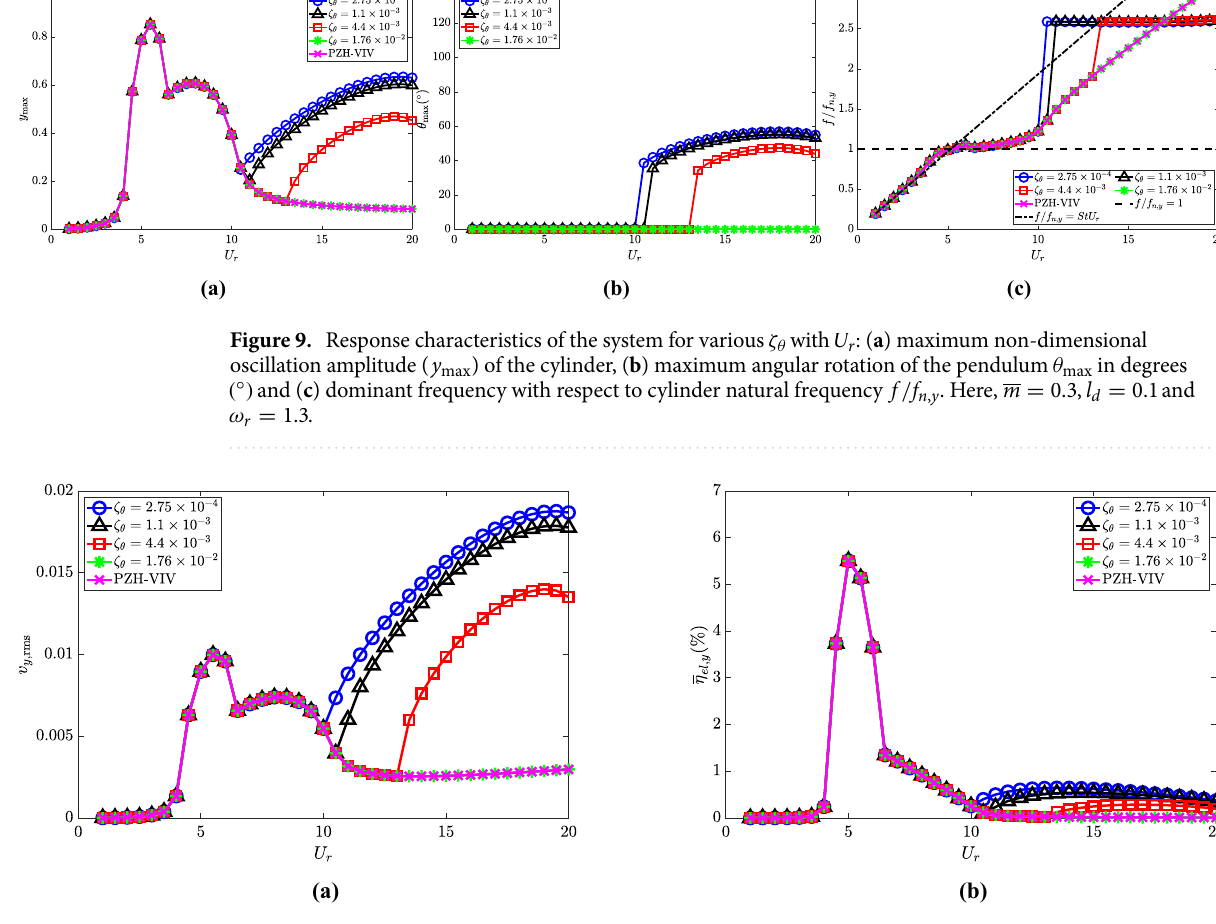
Figure 10. Effect of ζ θ in the introduction of NRGP with U r on: ( a ) electric tension v y ,rms , and ( b ) energy harvesting efficiency η el , y . Here, m = 0.3 , l d = 0.1 and ω r = 1.3